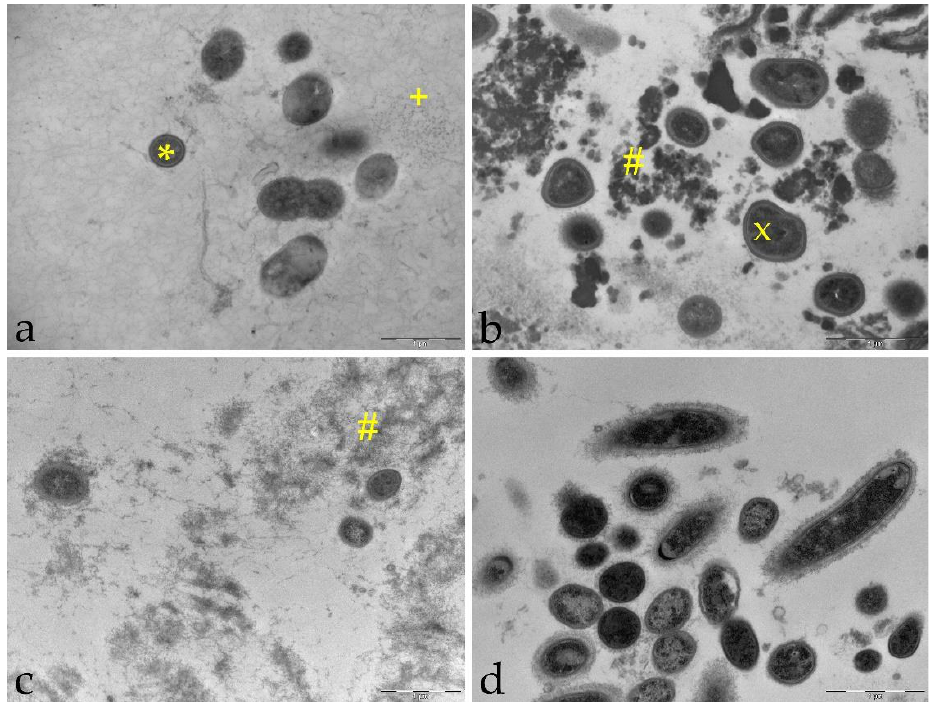
Figure 5. TEM images of saliva samples 1 min after rinsing with test substances. ( a ): negative control water, 18,500-fold magnification, ( b ): tannic acid, 23,000-fold magnification, ( c ): chitosan, 18.500-fold magnification, ( d ): positive control chlorhexidine, 23,000-fold magnification, intact morphology (*), loose protein-network (+), irregular morphology (x), protein aggregation (#).